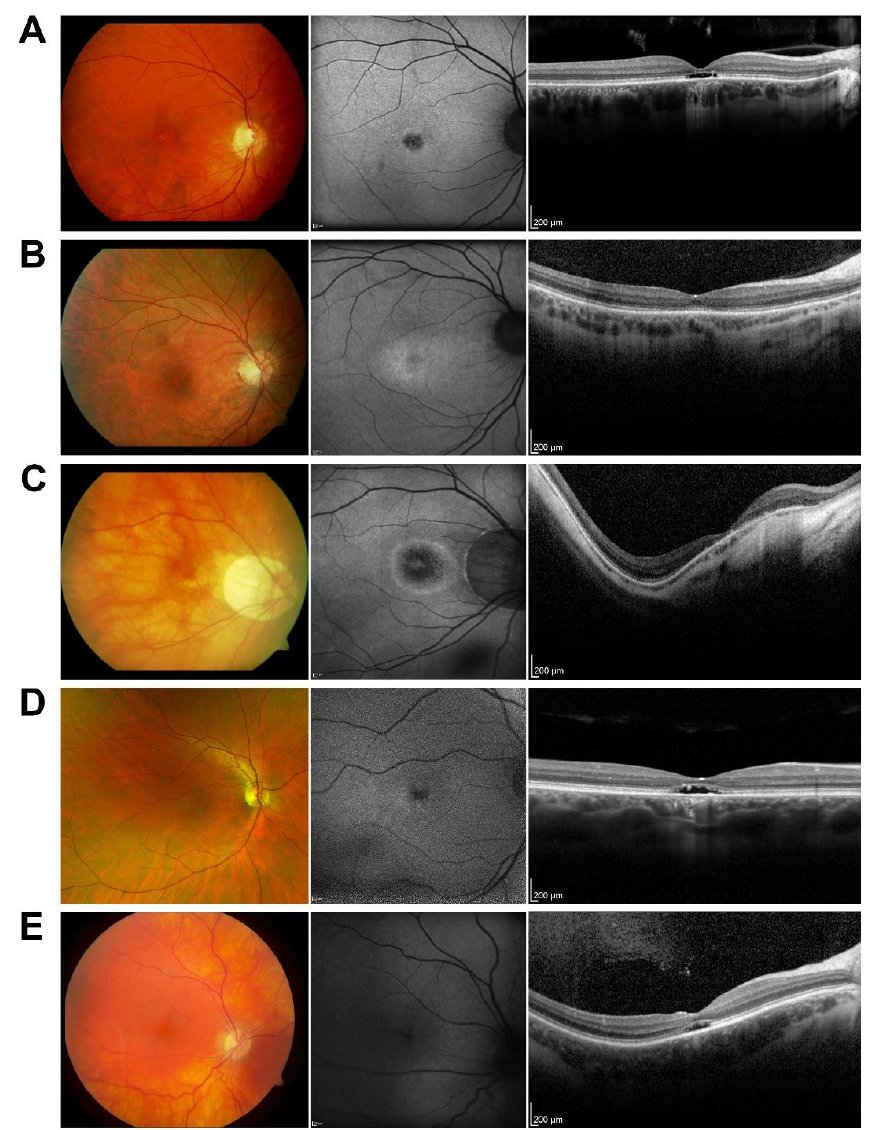
Figure 1. Fundus color picture, fundus autofluorescence and OCT scan of study patients. ( A ) ID 13 p.(Arg838Cys) (45-year-old female, logMAR 1.3, central reduced autofluorescence; first symptoms: vision loss at the age of 19). ( B ) ID 14 p.(Arg838Cys) (34-year-old male, logMAR 0.3, bull’s eye configuration in autofluorescence; first symptoms: vision loss). ( C ) ID 15 p.(Arg838Cys) (58-year-old female, logMAR 1.1, central reduced autofluorescence; first symptoms: color vision distortion and photophobia at the age of 54). ( D ) ID 16 p.(Arg838Cys) (41-year-old male, logMAR 1.1, central reduced autofluorescence; first symptoms: vision loss from birth on). ( E ) ID 24 p.(Arg838His) (26-year-old female, logMAR 1.3, normal